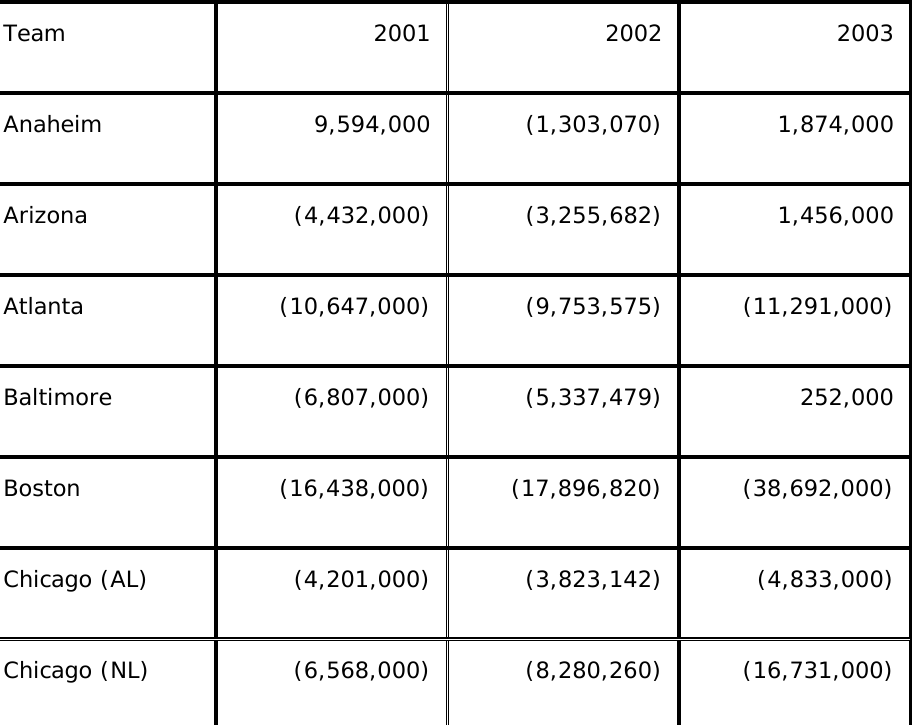
MLB R EVENUE S HARING F